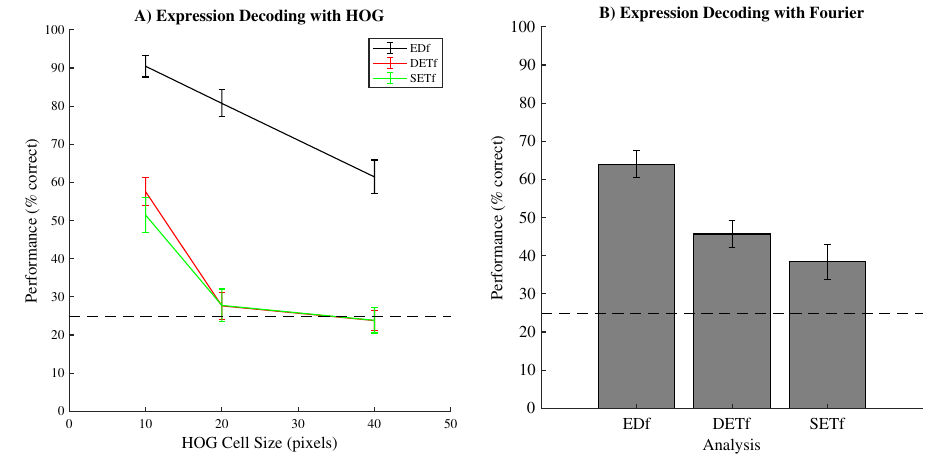
Figure 7. Average decoding performances across all folds (y-axis) based on different sets of HOG and Fourier features. The dotted black lines represent chance level performance. Errorbars represent the standard error of the mean. ( A ) Average performance for decoding emotional content based on HOG features using three different feature sets at three different spatial resolutions (x-axis). EDf (Emotion Decoding features) uses a feature set based on feature selection for emotional content decoding, DETf (Different Emotion Trials features) uses the features based on decoding initial eye movements towards faces with different emotional content and SETf (Same Emotion Trials features) uses the features based on decoding initial eye movements towards faces with the same emotional content. ( B ) Average performance for decoding emotional content based on Fourier features, again using three different feature sets (x-axis). Note that, for both HOG and Fourier features, the features based on decoding initial eye movements are suboptimal for decoding emotional content. Moreover, only the high-resolution HOG features based on decoding eye movement behaviour are relevant for decoding emotional